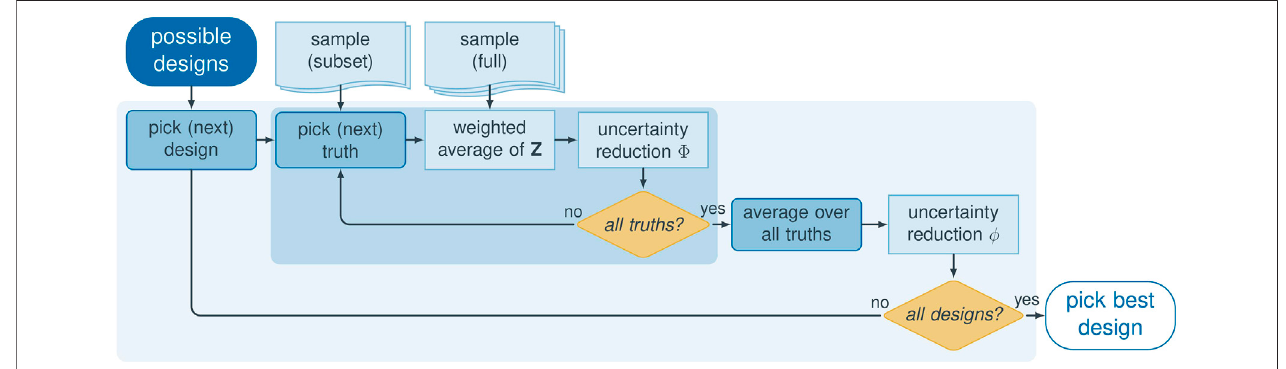
FIGURE 2 | Schematic illustration of the general preposterior data impact assessor procedure. Inner loop in dark blue, outer loop in light blue.